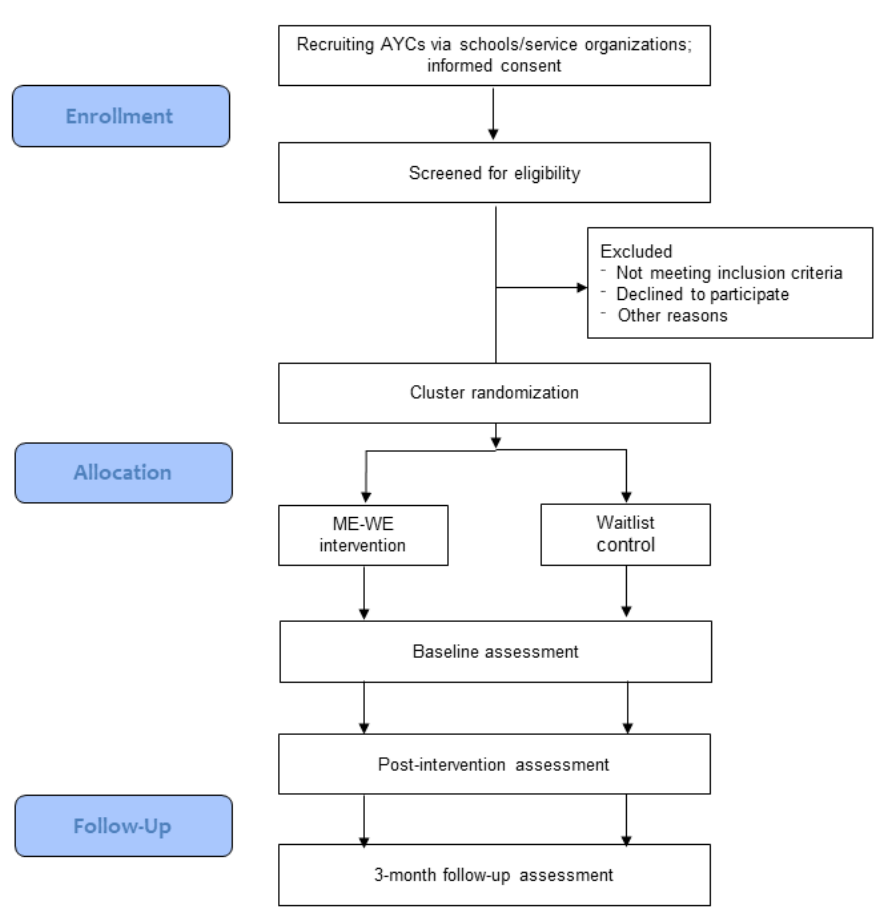
Figure 1. Consolidated standard of reporting trials (CONSORT) flow diagram for the original study protocol.